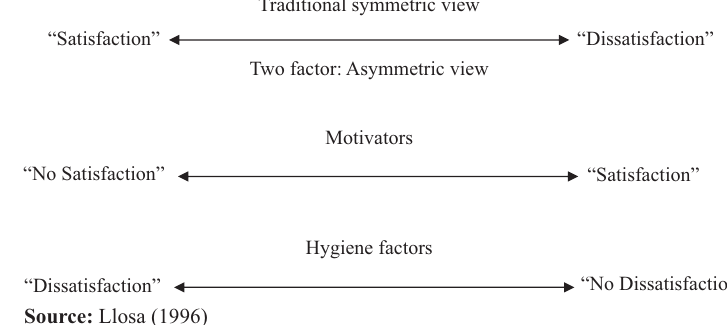
Figure 1. Two approaches of the asymmetry of (dis)